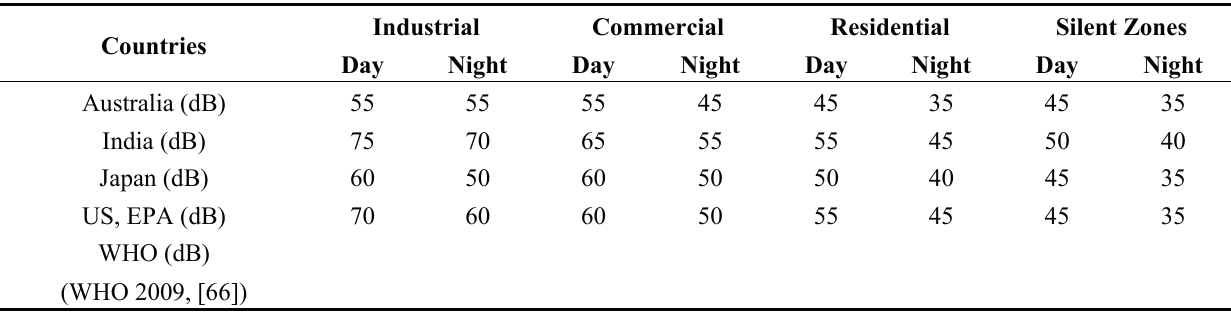
Table 1. A-weighted noise level standards in selected countries of the world [65]. Industrial Commercial Countries